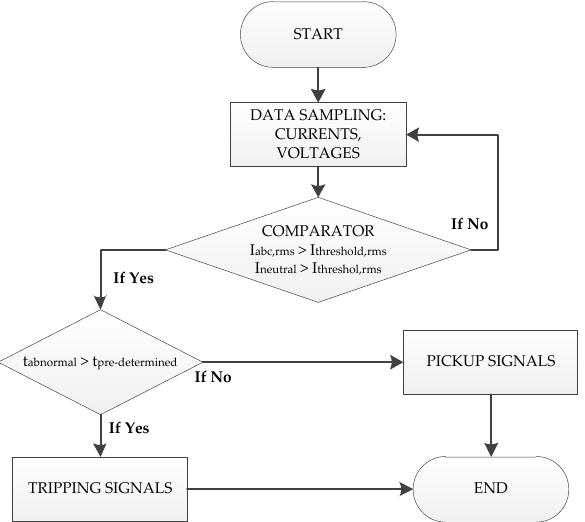
Figure 4. Operating principle of overcurrent relays/reclosers ( I abc , rms — phase currents; I neutral , rms — neutral currents; I threshold , rms — threshold currents; T abnormal — the time is counted from fault inception; T pre-determined — the defined fault detection time; Tripping signal — is given by relays/reclosers; and Pick-up signal — to give a fault alarm from a protective relay.